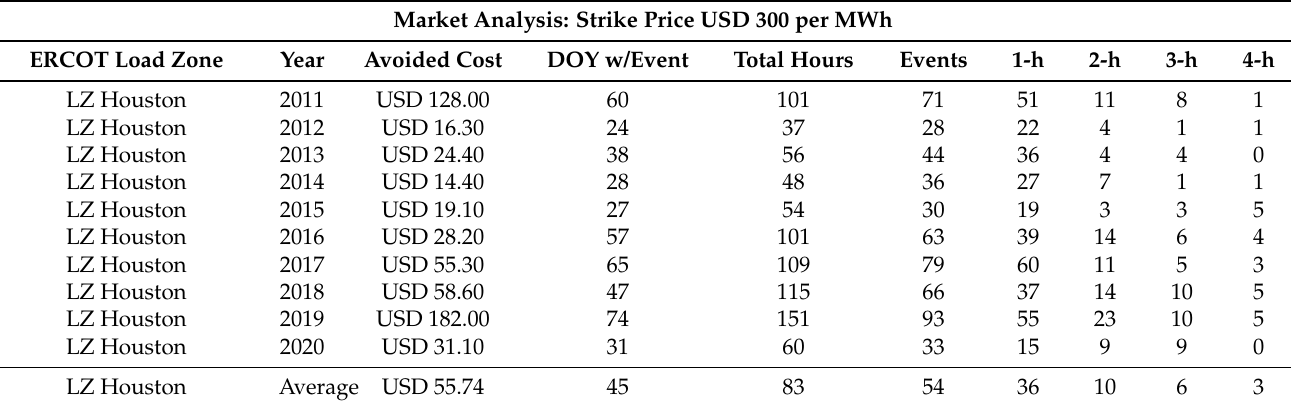
Table 2. Annual avoided cost of a load-shifting program deployed in ERCOT assuming a USD 300 per MWh strike price.